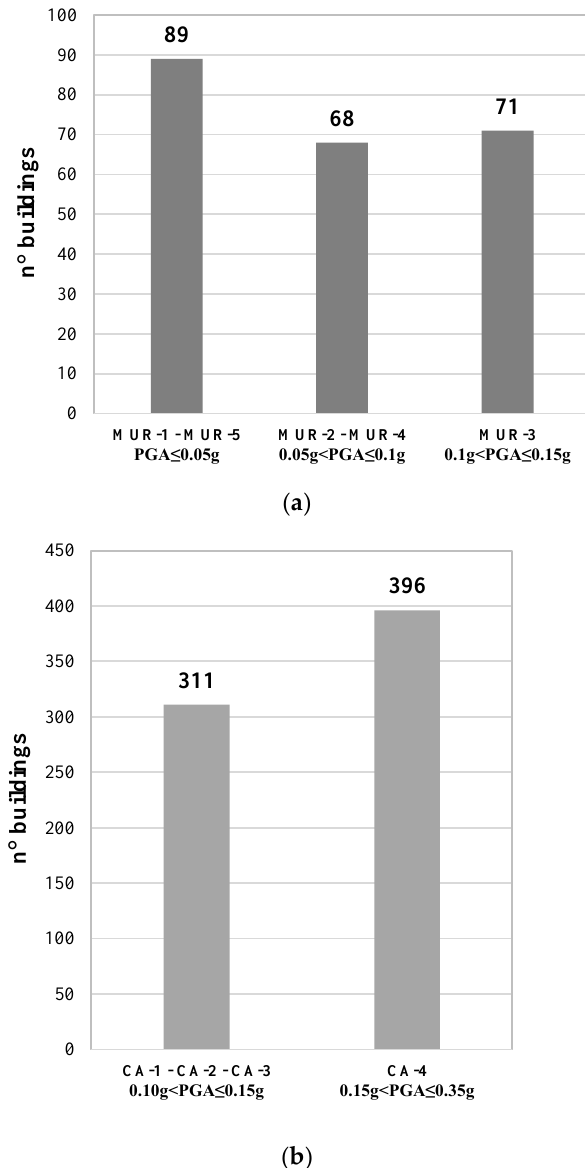
Figure 8. Classes of peak ground acceleration (PGA) capacity according to S&C method for 935 Figure8. Classesofpeakgroundacceleration(PGA)capacityaccordingtoS&Cmethodfor935buildings: buildings: ( a ) 228 masonry buildings and ( b ) 707 RC buildings. ( a ) 228 masonry buildings and ( b ) 707 RC